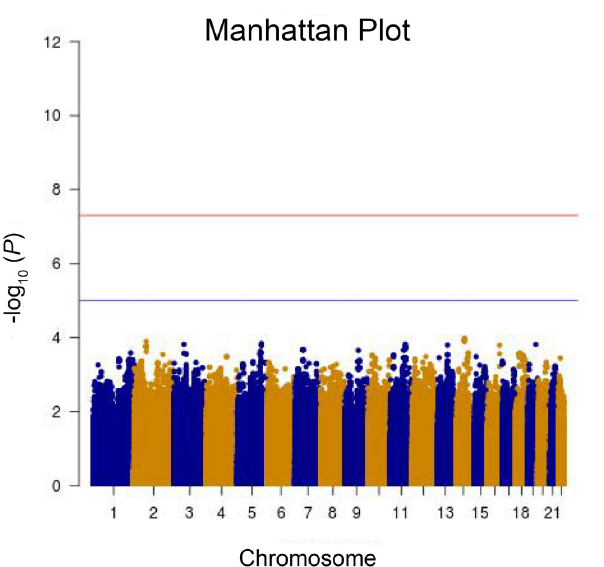
ranked by P value were selected, and a gene set consisting of 60 genes encoding protein or non-coding RNA (ncRNA) was revealed and summarized in S2 Table. To analyze the molecular and functional characteristics of top 500 SNPs mapped genes, gene ontology (GO) enrichment analysis was subsequently performed only in 38 genes encod- ing protein, and results of GO analysis under three categories of biological process (BP), molecular function (MF) and cellular component (CC) with the P value < 0.05 were summa- rized in S4 Table, and top 10 terms of the three categories were visualized in Fig 3, respectively.